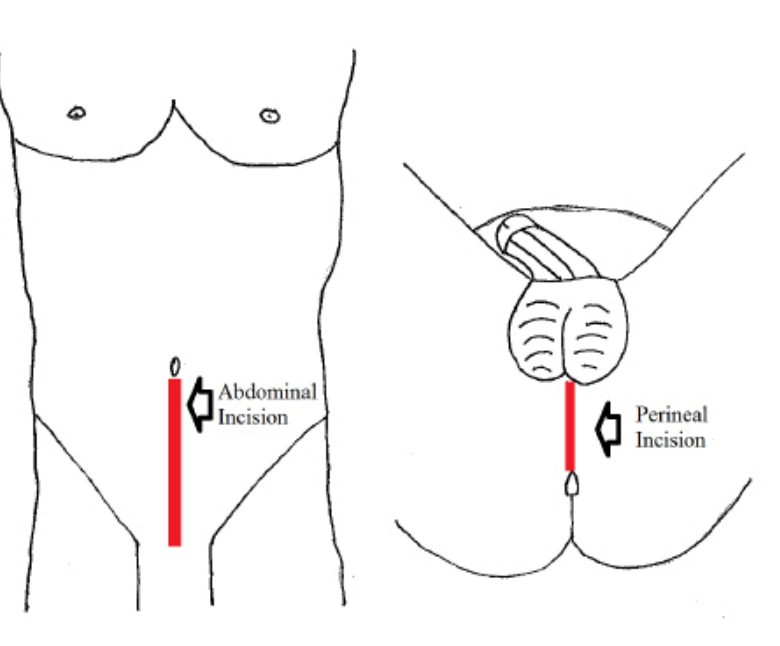
Figure 2 - Abdominal and perineal